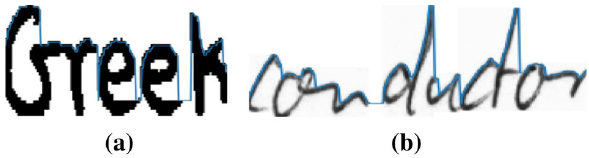
Fig. 4 Two examples of the estimated upper profile of the word images. The blue curves represent the upper profiles